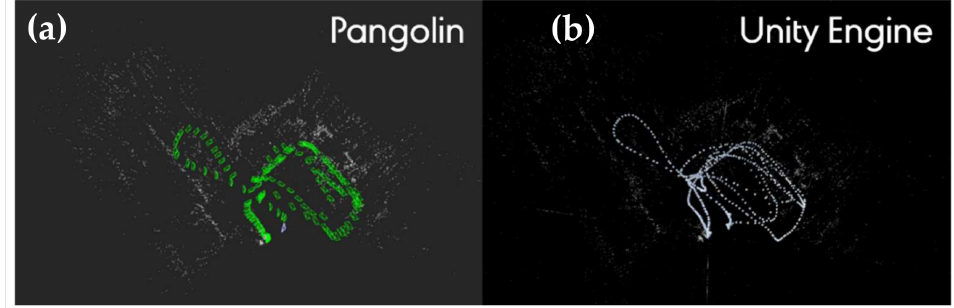
Figure 5. The result of SLAM visualization; ( a ) for desktop (Pangolin); ( b ) mobile device (Unity).